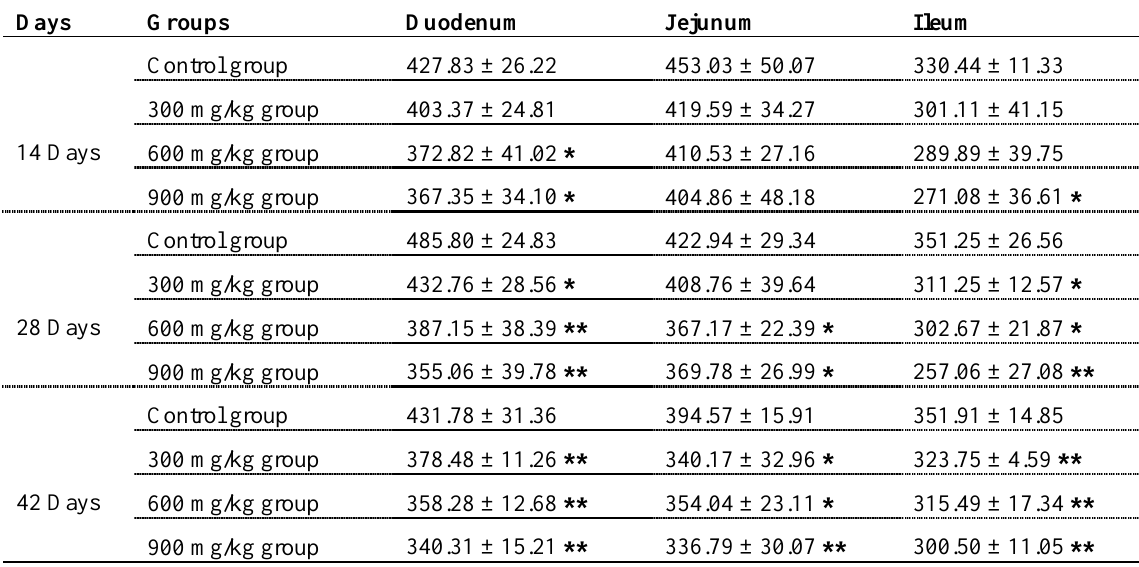
Table 3. Change of the GSH-Px activity (U/mgprot) in the intestinal mucosa. Days Groups Duodenum Jejunum